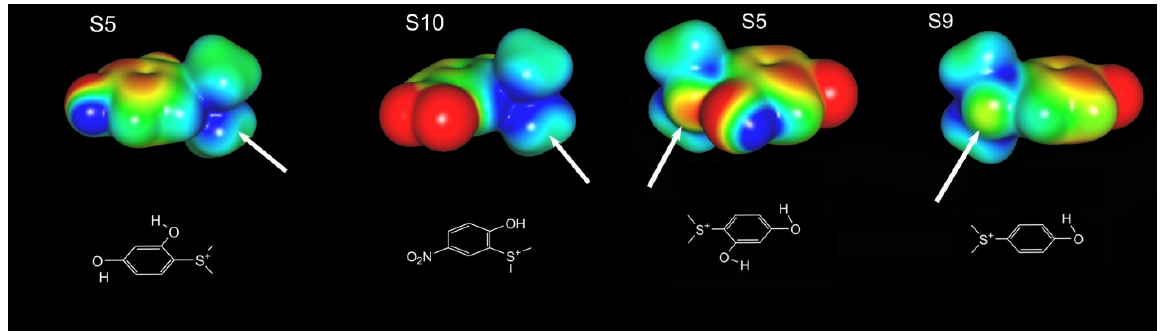
Figure 9. Molecular electrostatic potential (MEP) of compounds S5 , S9 , and S10 . Positive regions are colored blue; negative regions are colored red. The arrow points to the sulfonium sulfur atom. The left panel compares the MEP of S5 and S10 ; the right panel compares the MEP of S5 and S9 . Note that S5 is presented from two different perspectives in the two figures to best highlight differences between it and either S9 or S10 .